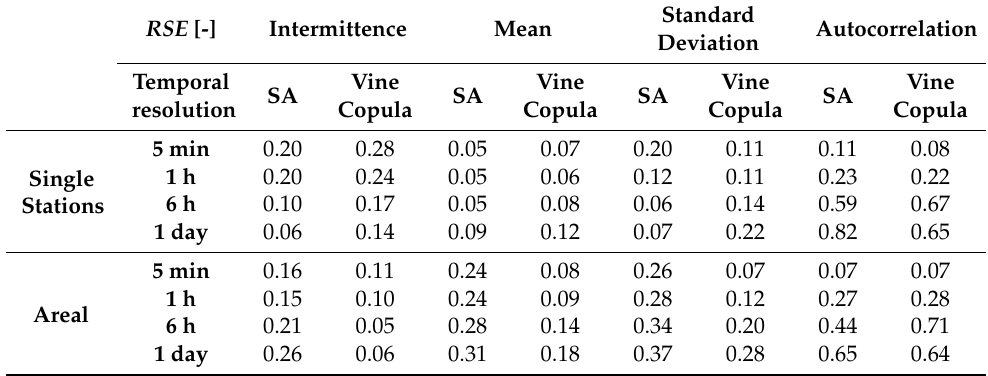
Table 6. Evaluation of performance based on wet time steps for different temporal resolutions resulting from two multisite models and presented for all stations as RSE for single stations and areal